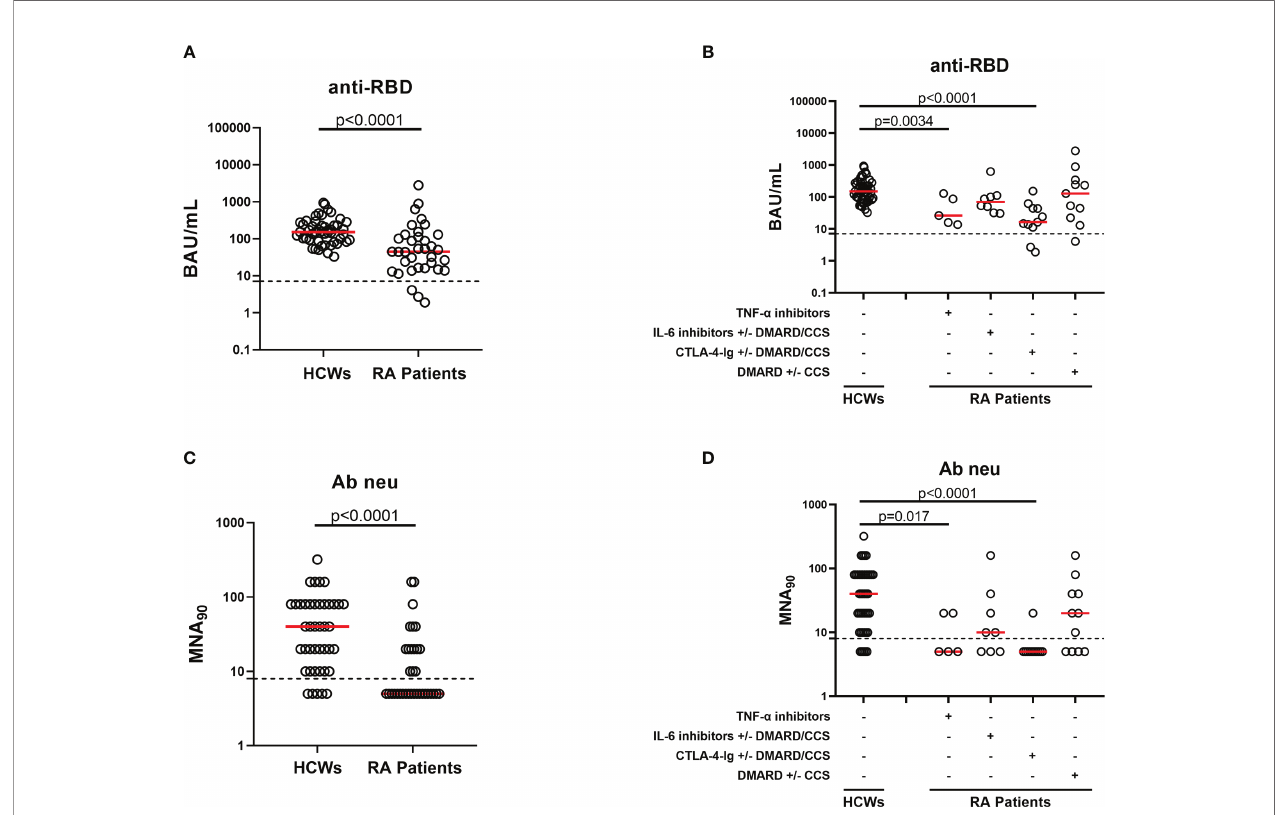
FIGURE 2 | Humoral response elicited by SARS-CoV-2 vaccination after 6 months in HCWs and RA patients. Evaluation of SARS-CoV-2-speci fi c anti-RBD (A, B) and neutralizing (C, D) antibodies 6 months after vaccination in the total of HCWs (n = 49) and RA patients (n = 35) analyzed. (B, D) RA patients were divided according to drug treatment into four groups: TNF- a inhibitors (n = 5), IL-6 inhibitors with or without DMARD/CCS (n = 8), CTLA-4-Ig with or without DMARD/CCS (n = 11), and DMARD with or without CCS (n = 11). Anti-RBD (A, B) and neutralizing (C, D) antibodies were quanti fi ed in serum samples and expressed as binding antibody units (BAU)/ml and reciprocal of dilution (MNA 90 ), respectively. Medians were indicated by red horizontal lines, and dashed lines represent the cutoff of each test (anti-RBD: 7.1 BAU/ml and MNA 90 : 8). Mann – Whitney U-test with Bonferroni correction (p ≤ 0.0125) was used for the statistical analysis. SARS-CoV-2, severe acute respiratory syndrome coronavirus 2; CCS, corticosteroid; DMARDs, disease-modifying antirheumatic drugs; RA, rheumatoid arthritis; RBD, receptor-binding domain; HCWs, health care